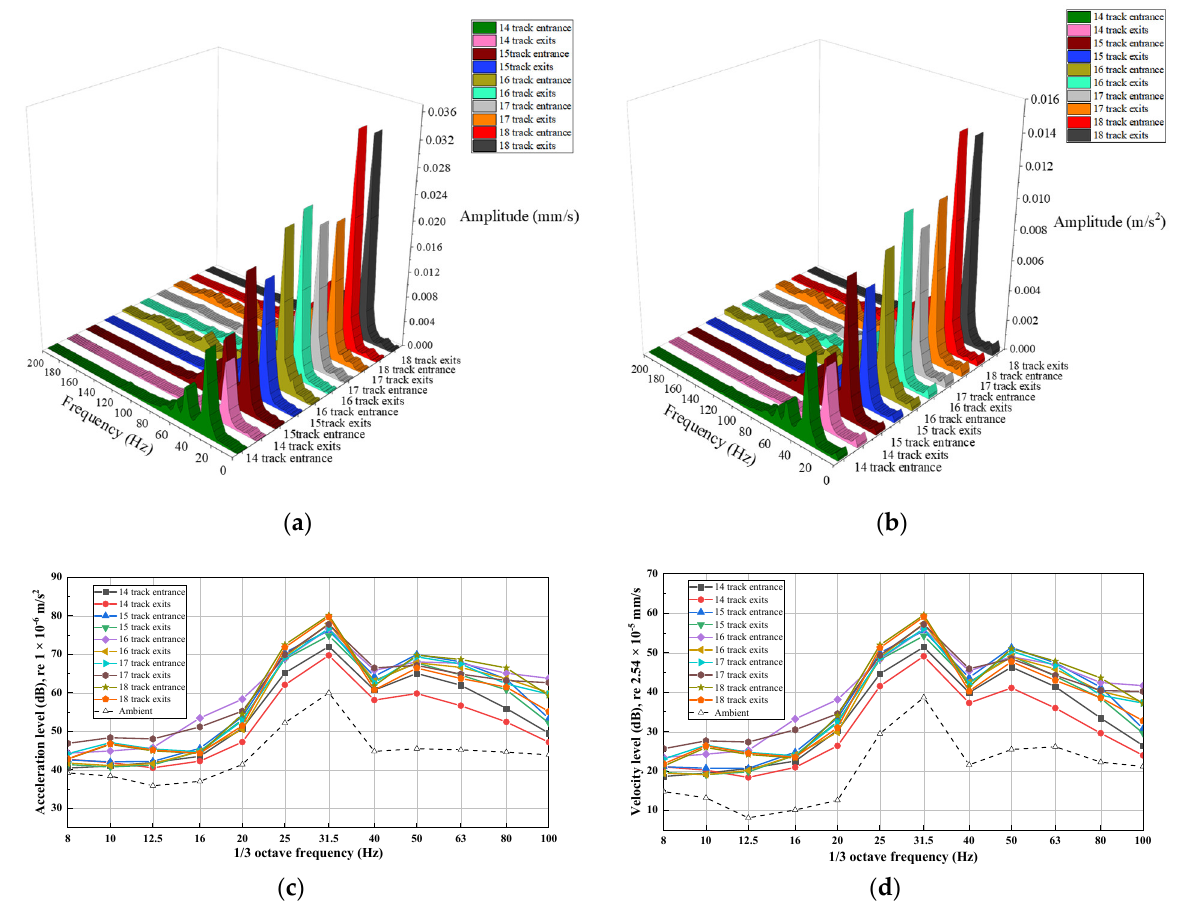
Figure 8. ( a ) Results of the building vibration acceleration caused by a train passing over different tracks in the frequency domain; ( b ) results of the building vibration velocity caused by a train passing over different tracks in the frequency domain; ( c ) results of the building vibration acceleration over one-third octave caused by a train passing over different tracks; ( d ) results of building vibration velocity over one-third octave caused by a train passing over different tracks.